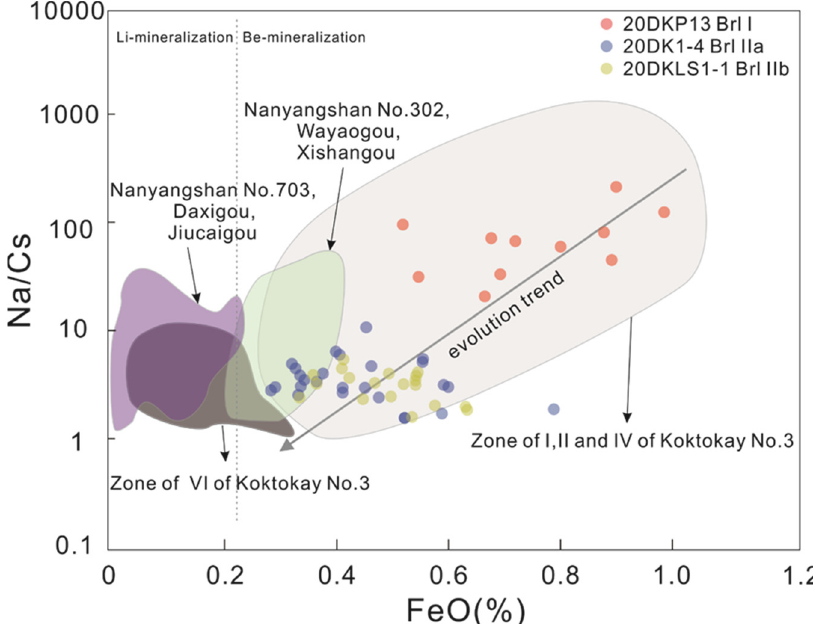
Figure 10. Plots of FeO vs. Na /Cs. The contents of FeO and Na /Cs values of beryl from the Koktokay No. 3 pegmatite and the East Qinling Lushi pegmatites are from [7,8].